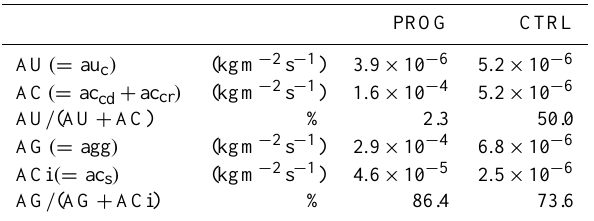
Figure 8. Mean vertically integrated autoconversion (AU) and ac- cretion rates (AC) of PROG for the year 2000, such as the fraction of AU to the total collection rate (AU + AC). Table 3. Global annual mean conversion rate burdens for both cloud liquid and ice for CTRL and PROG for the year 2000.